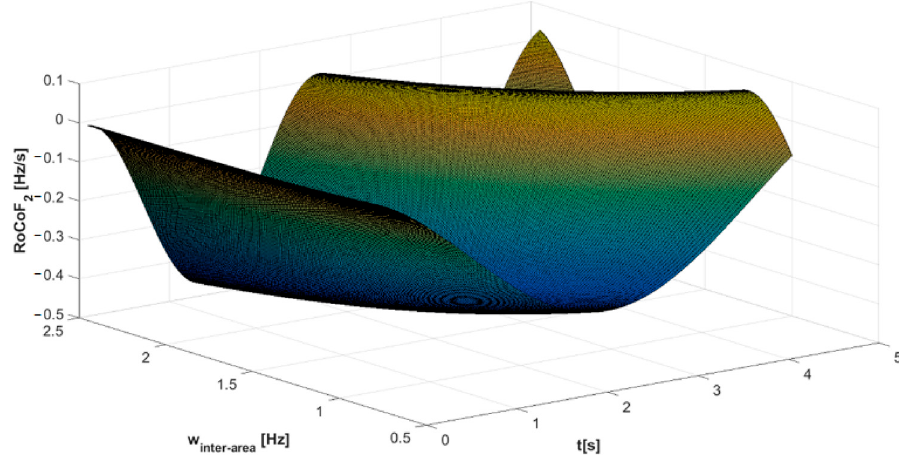
Figure 6. The value of RoCoF in area 2 for different frequencies of inter-area oscillations.